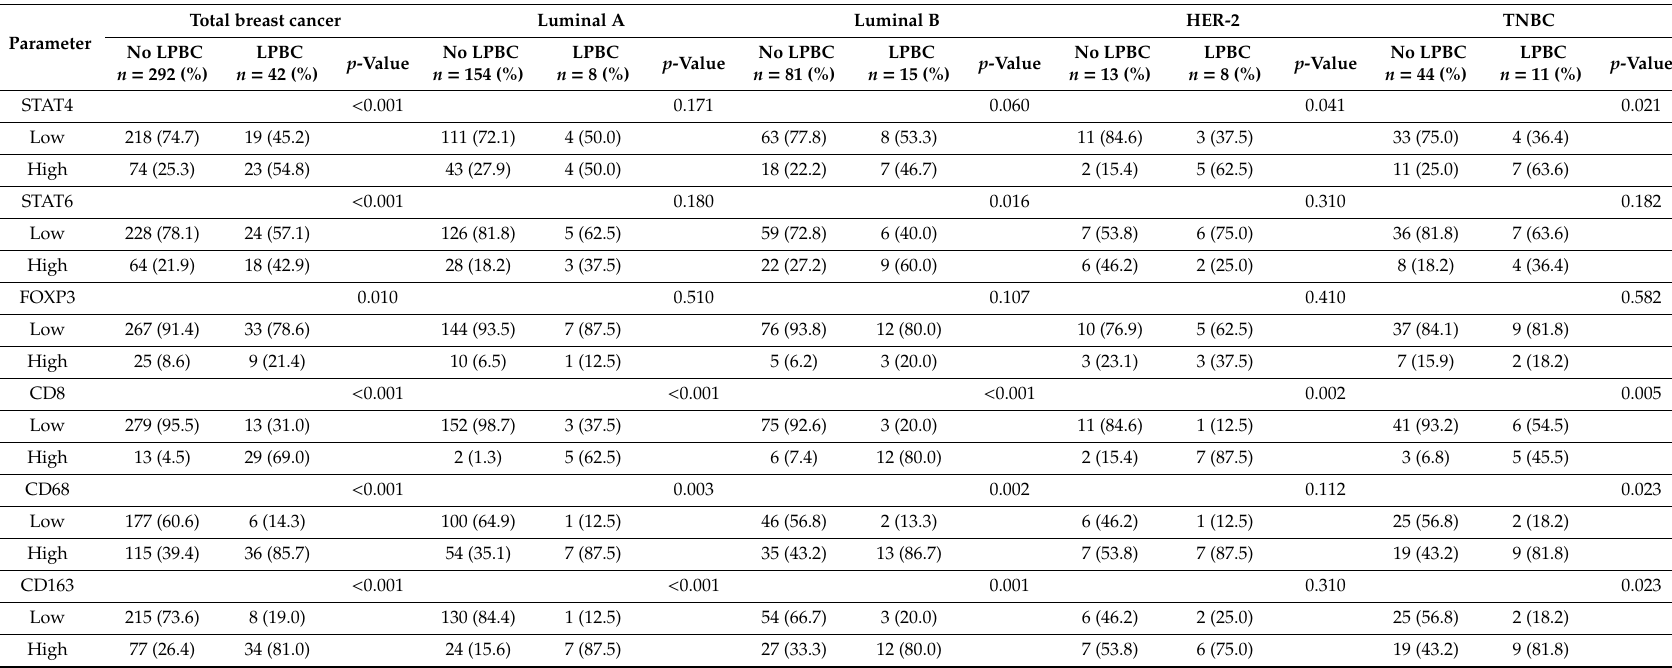
Table 3. Expression of immune cell subtype-related proteins in molecular subtypes of breast cancer based on LPBC